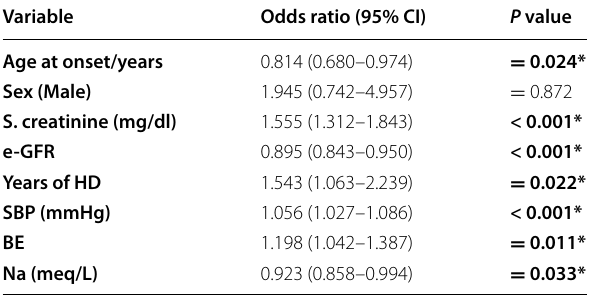
*Significant p value < 0.05. Younger age of disease onset, higher serum creatinine levels, lowered e-GFR, longer duration on hemodialysis, lowered serum sodium levels and hypertension, all are predictors of fatigue severity in CKD patients